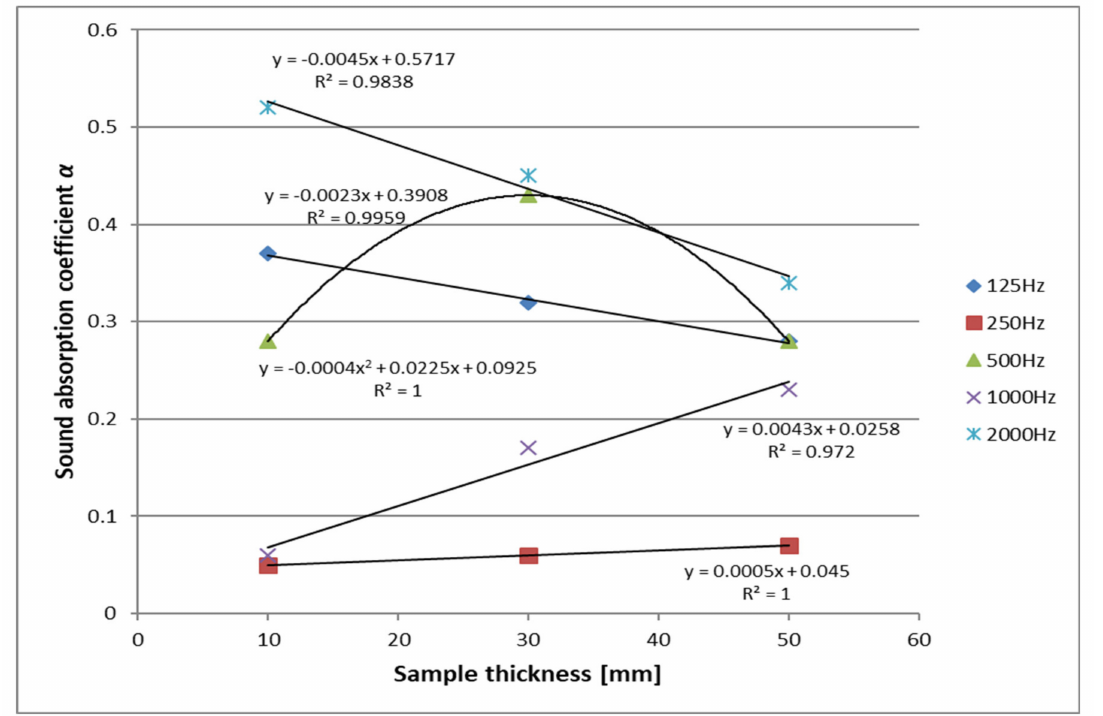
Figure 10. Sound absorption coefficient dependence on the thickness of the sample of mixture Z3 (the trendline is reported for each set of measurements).